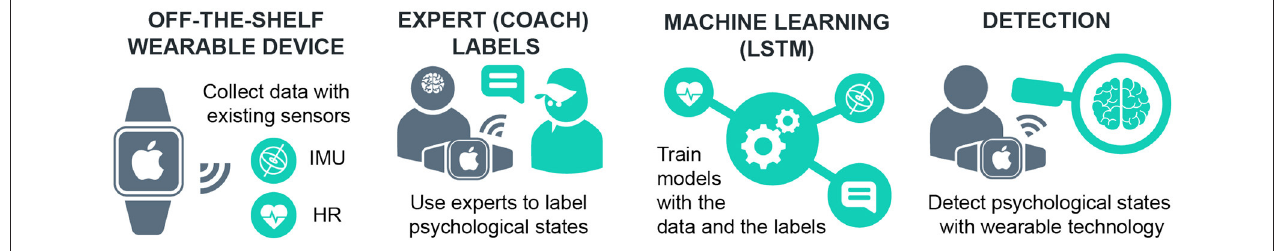
FIGURE 1 | Summary of our approach to detect psychological states with wearable technology, expert labels and machine